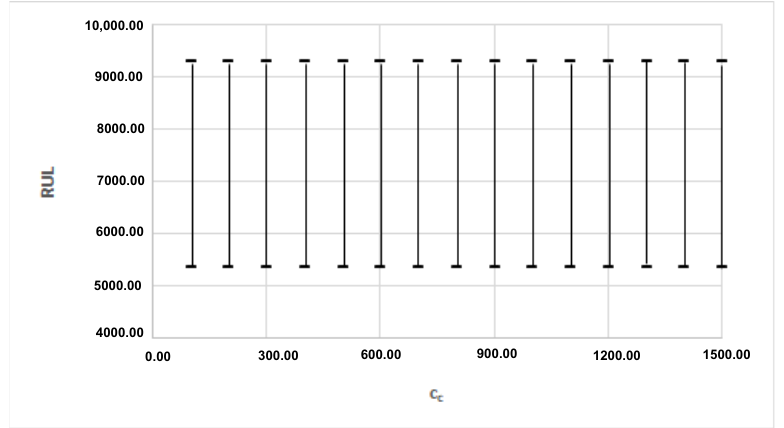
Figure 17. Variations of [ RUL lim